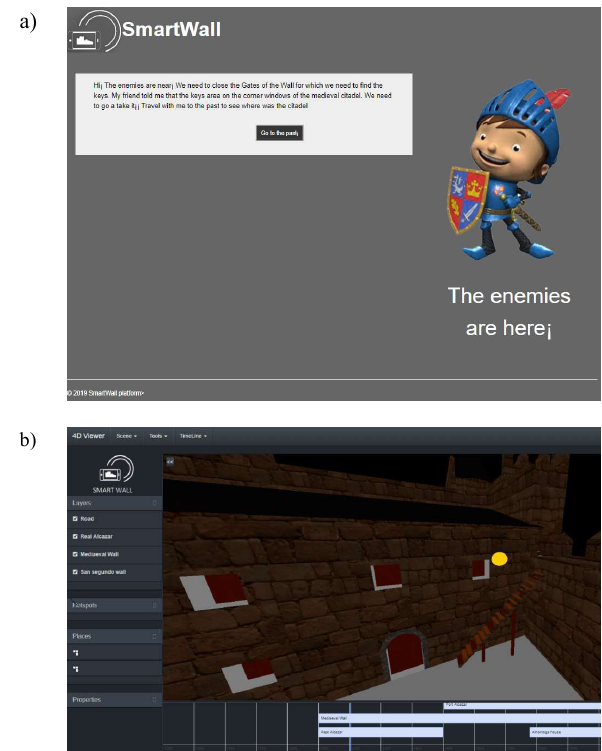
Figure 11. Role of the diachronic reconstructions in the education of scholars: a) HTML page that appears when the scholar is in the final stage of the game and; b) appearance of the 4D viewer highlighting the area on which is placed the key and is related with the visible sign presented nowadays on the Wall.